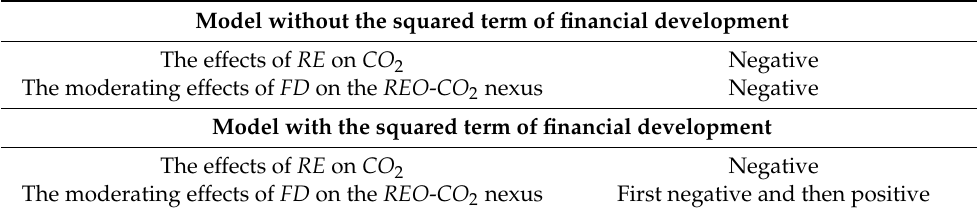
Table 5. Summary of the main